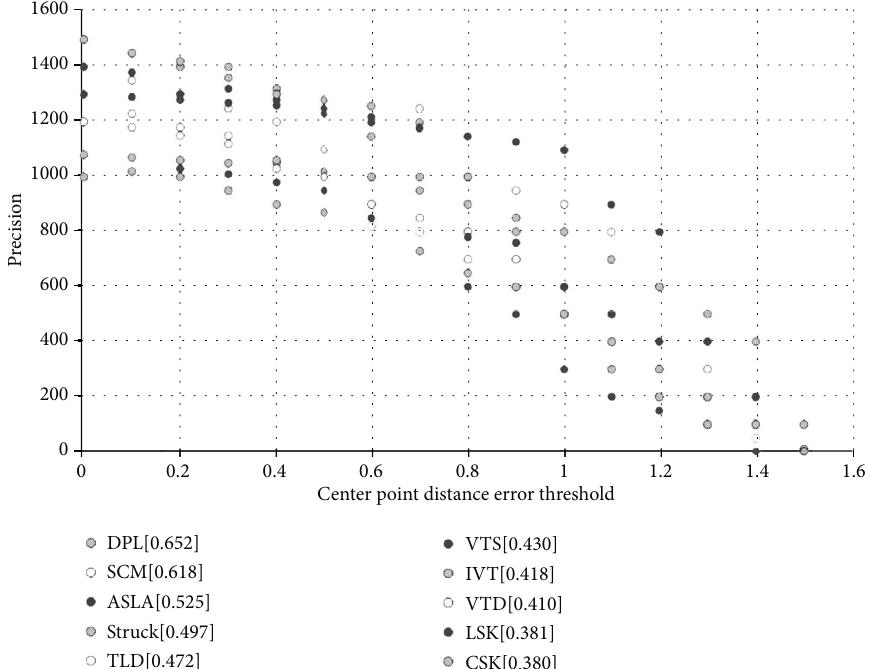
Figure 6: Overall average success rate of target tracking algorithm in all guidance